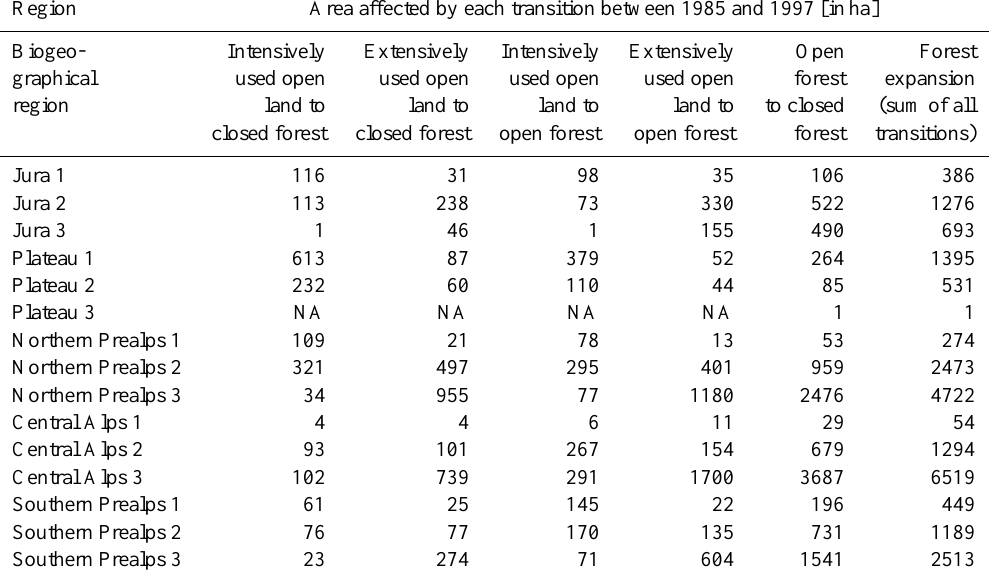
Table A4. Area affected by each type of transition between 1985 and 1997. Numbers 1–3 behind the biogeographical regions indicate the elevation (1 is below 600m, 2 is 600–1200m, 3 is above